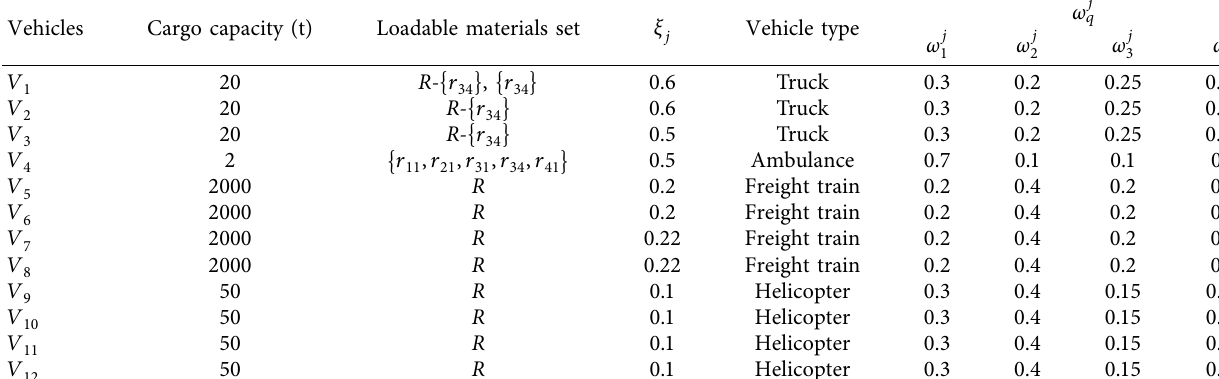
Table 3: Information on